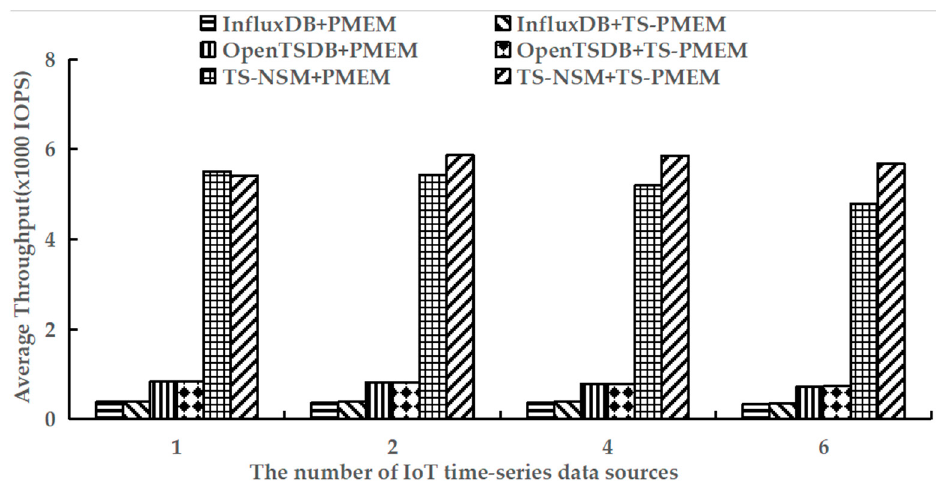
Figure 6. Average write throughput under testworkloadb.